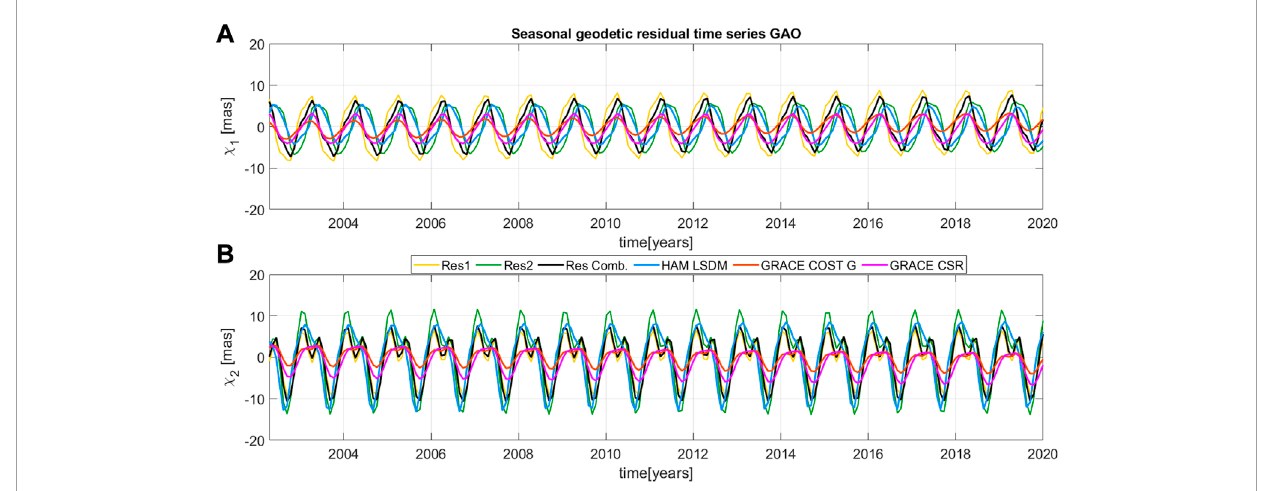
FIGURE 6 Comparison of seasonal oscillations of the equatorial components of the χ 1 (A) and χ 2 (B) geodetic residuals (Res1, Res2, Res Comb.) with gravimetric-based excitation determined from a single GRACE/GRACE-FO solution (CSR), combined GRACE/GRACE-FO solution (COST-G), and HAM LSDM hydrological